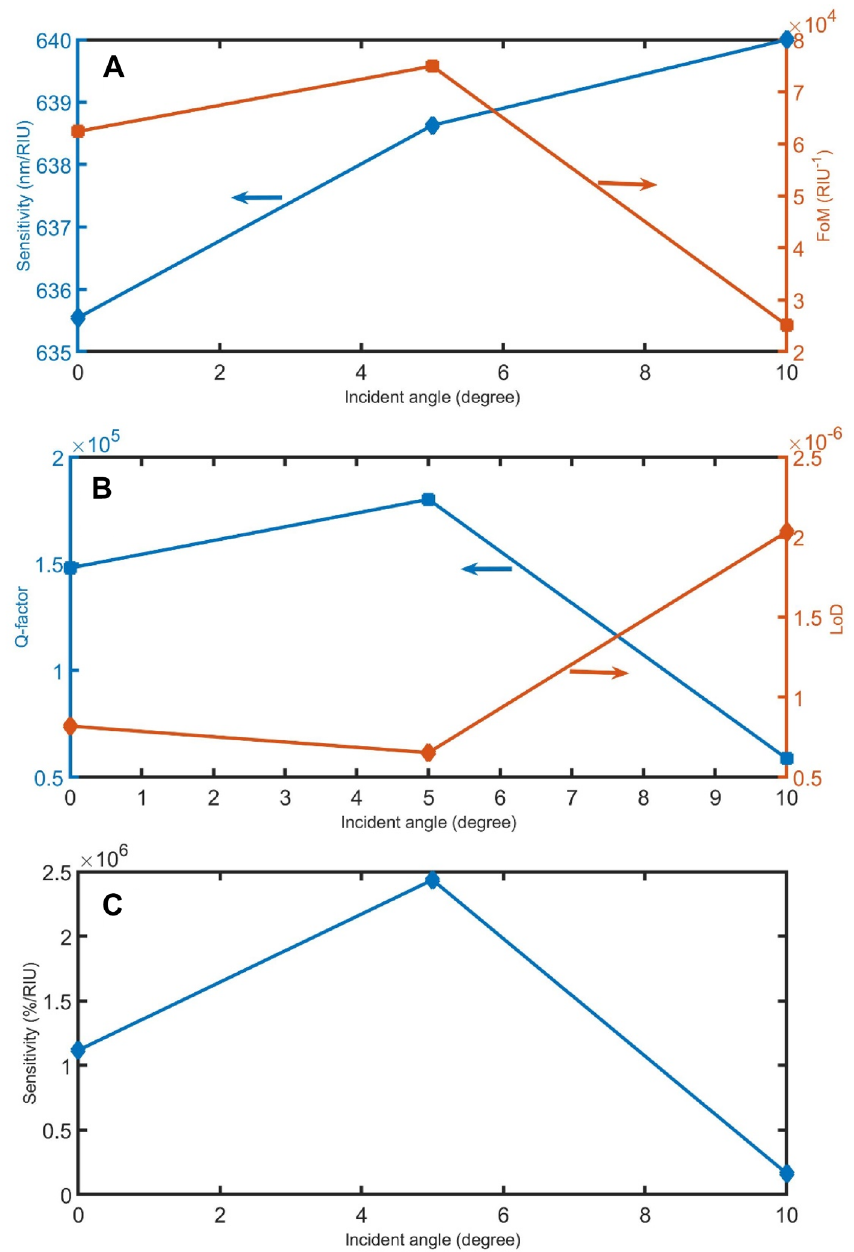
Figure 14. The ( A ) sensitivity in nm/RIU and FoM, ( B ) Q-factor and LoD, and ( C ) sensitivity in %/RIU, with varying the incident